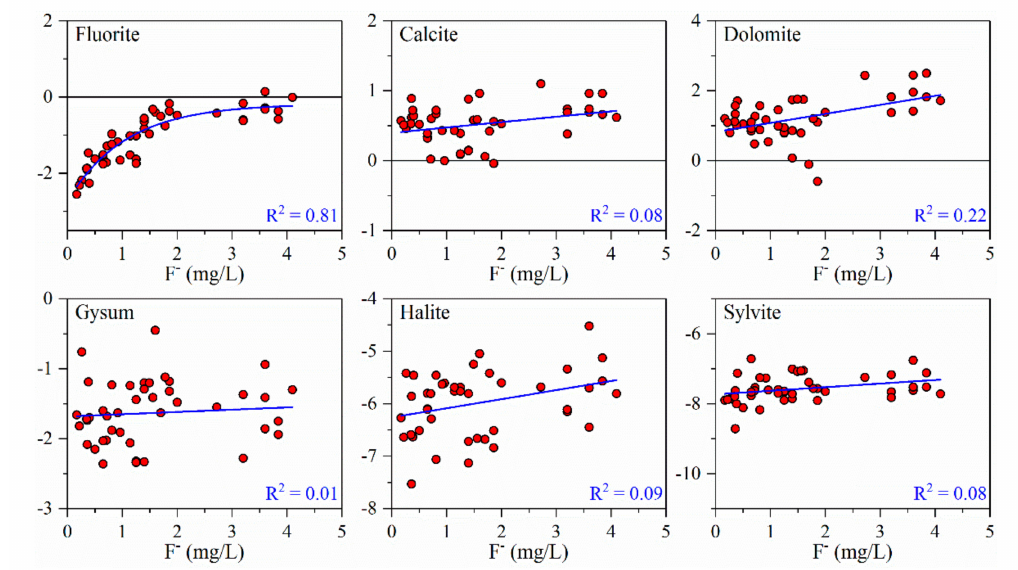
Figure 7. Saturation indices of the minerals in groundwater of the Jiaolai Basin, Jiaodong Peninsula, eastern